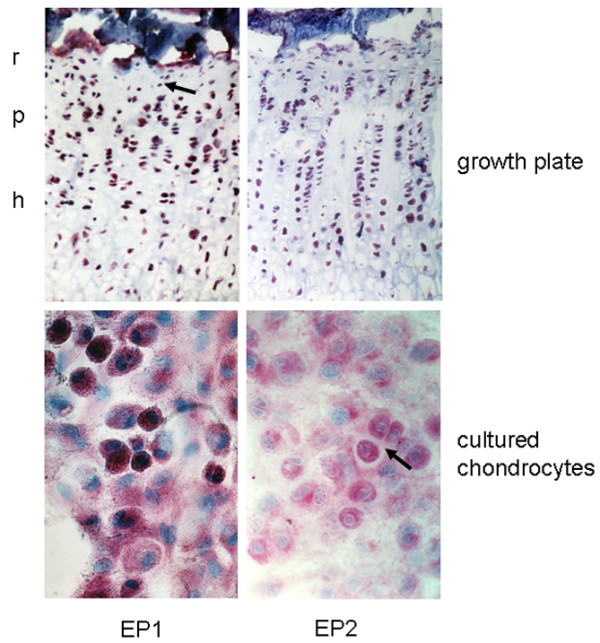
Immunohistochemical detection of EP1 and EP2 receptor in rat growth plates and in cultured chondrocytes. Protein expression of EP1 and EP2 receptor was studied using isoform-specific antibodies. The EP1 receptor showed strong expression in the proliferative and hypertrophic zone but marginal expression in the reserve zone, with some negative cells (marked by arrow). In contrast, the EP2 receptor was distributed throughout the whole growth plate. In vitro the EP1 and EP2 receptors were only expressed in subpopulations. EP1 showed strong positivity in chondrocytes organised in a cobblestone pattern and surrounded by matrix, whereas fibroblastic-shaped cells were only occasionally and moderately positive for EP1. The highest expression for EP2 could be demonstrated in dividing cells and polygonal cells embedded in matrix (marked by arrow). In fibroblastic cells, only minimal to slight positivity was found in a small number of cells. Magnification 200 × . r, reserve zone; p, proliferative zone; h, hypertrophic zone.